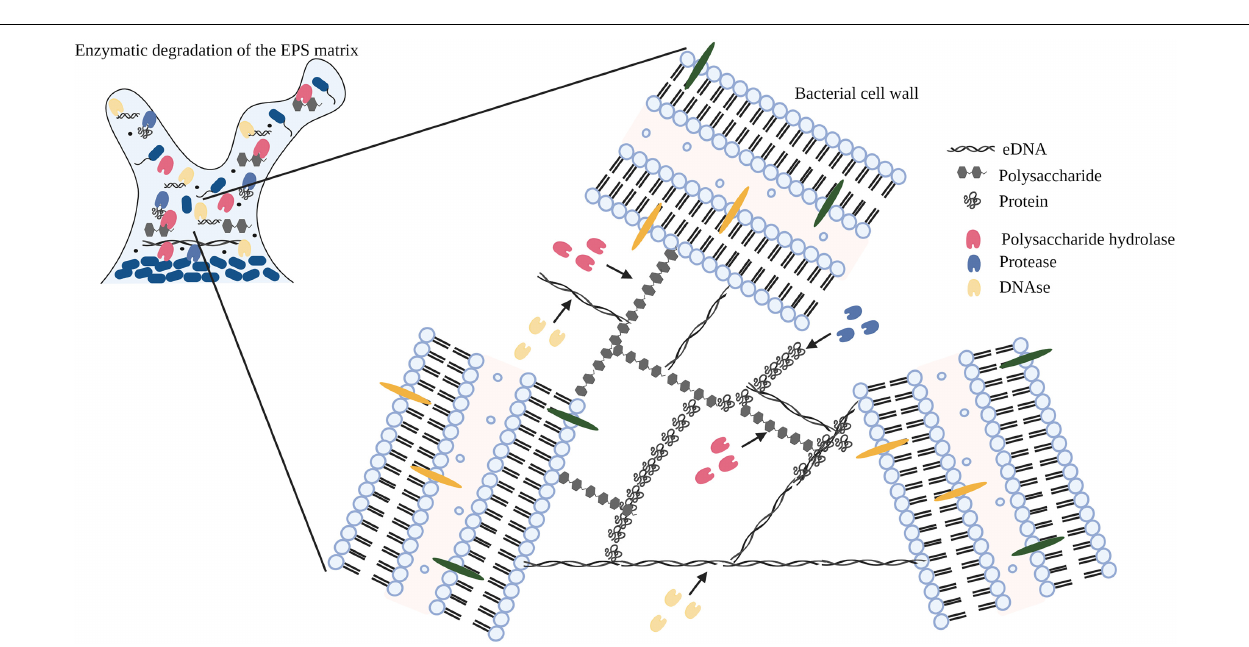
FIGURE 1 | Flow diagram showing the general mechanism of action of enzymes on biofilm formed during cheese manufacturing. Image adapted from Nahar et al. (2018) and Johnson et al. (2021) with permission and was re-created with the BioRender software.